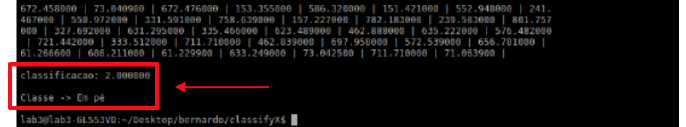
Figure 12. The output of the system for the given pose, depicted in Figure 11b